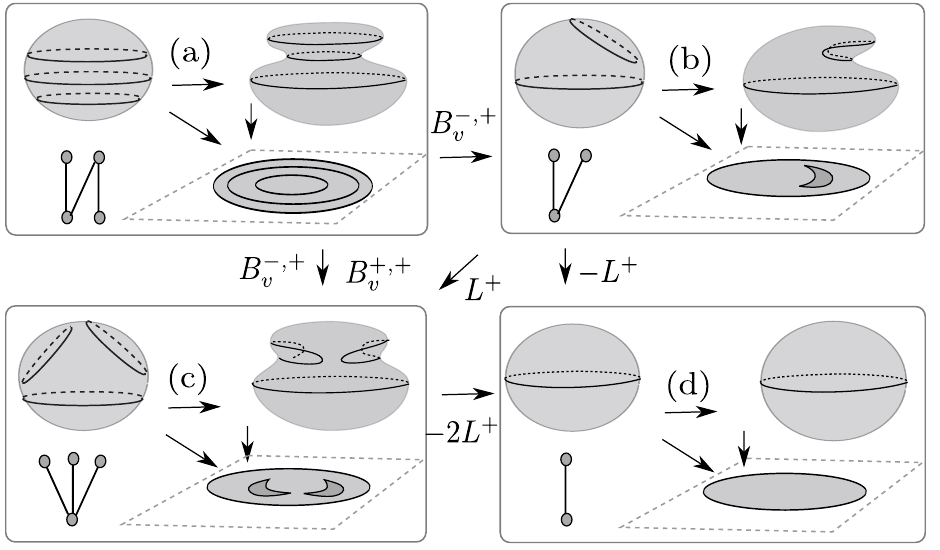
Figure 9. Examples of lips transitions L + and beaks transitions B ± , + v (see